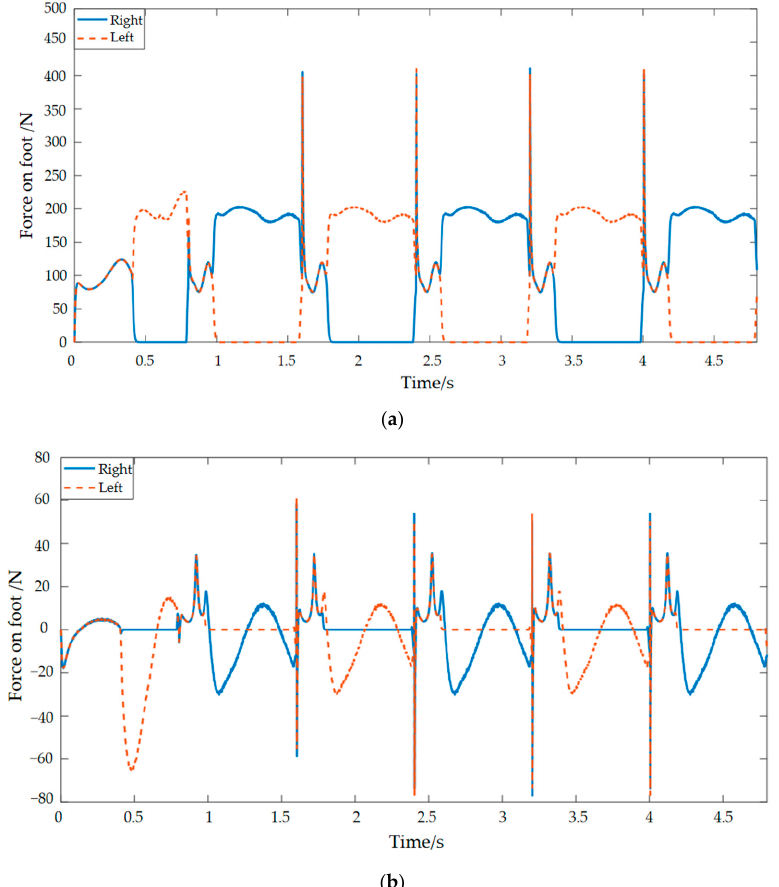
Figure 2. Humanoid robot with ground contact forces: ( a ) vertical direction and ( b ) horizontal direction.